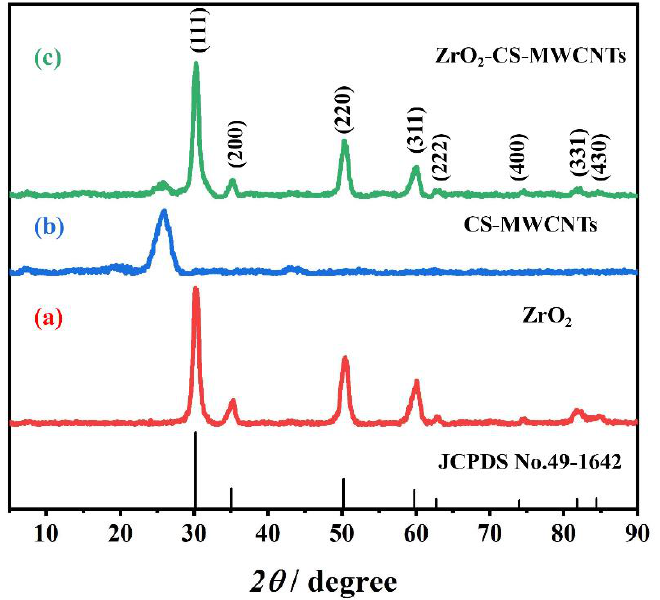
Figure 1. The X-ray diffraction (XRD) patterns of ZrO 2 ( a ), CS-MWCNTs ( b ) and ZrO 2 -CS-MWCNTs composites ( c ).